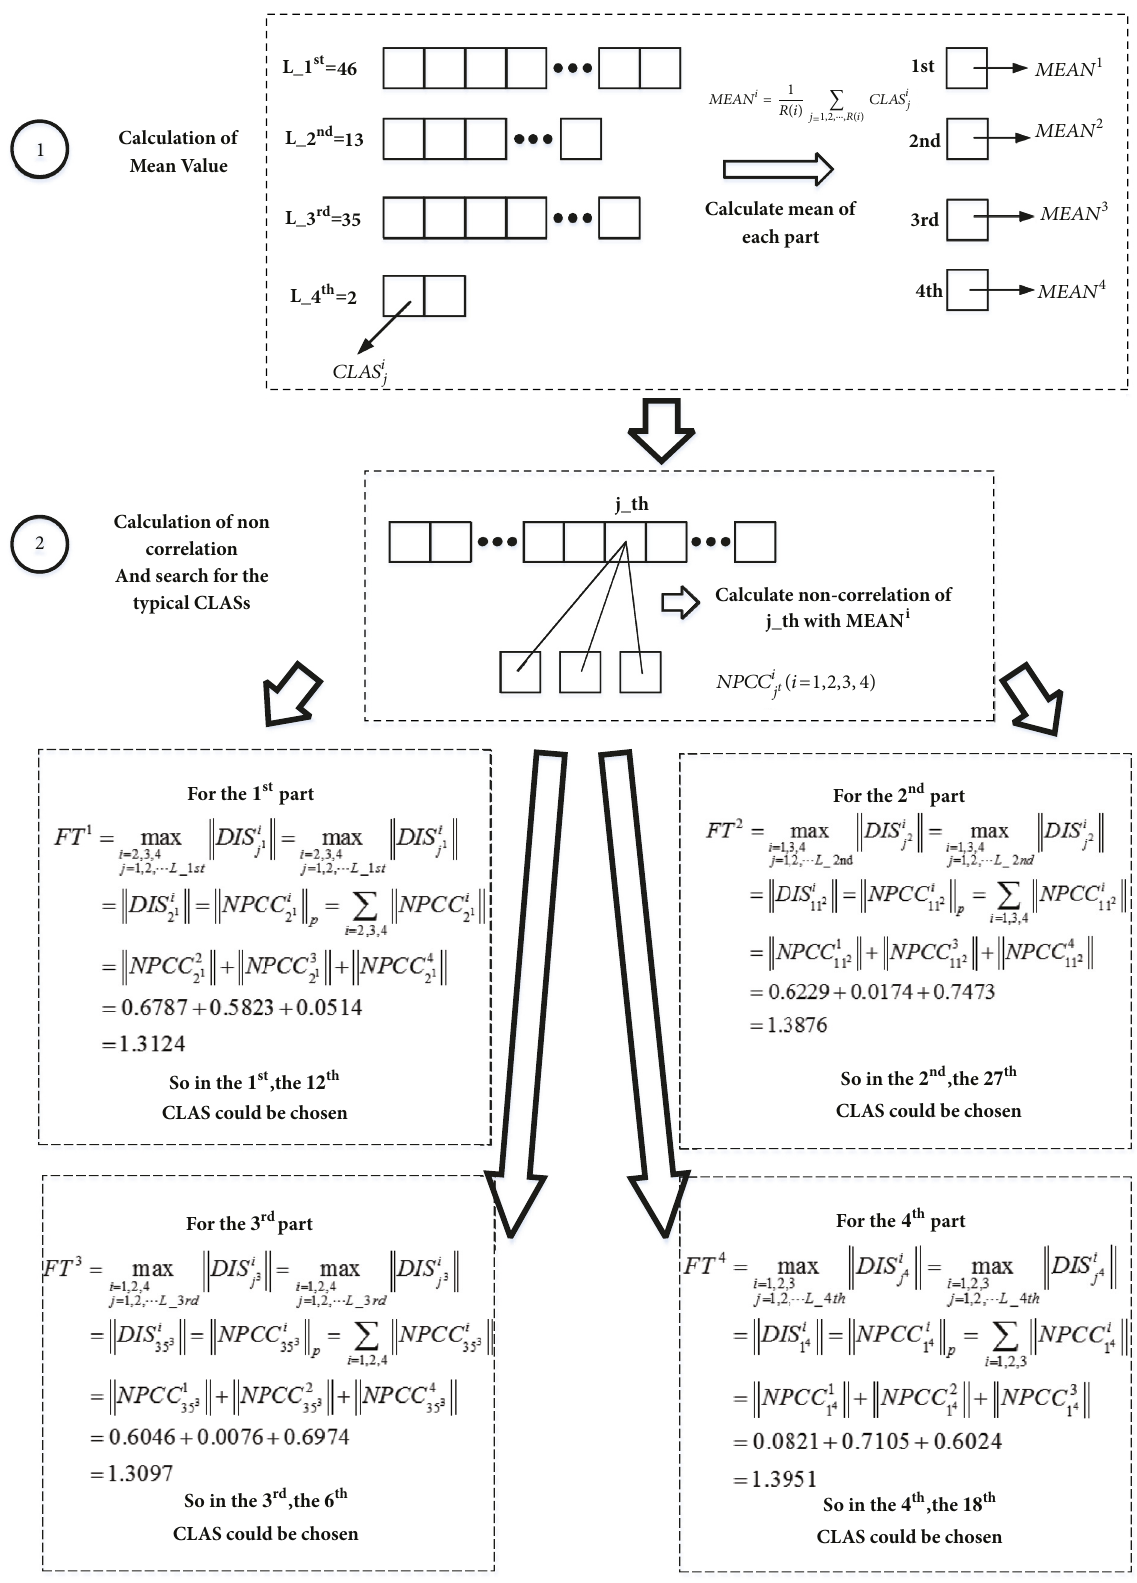
Figure 10: Steps 3 and 4 in proposed algorithm of sample